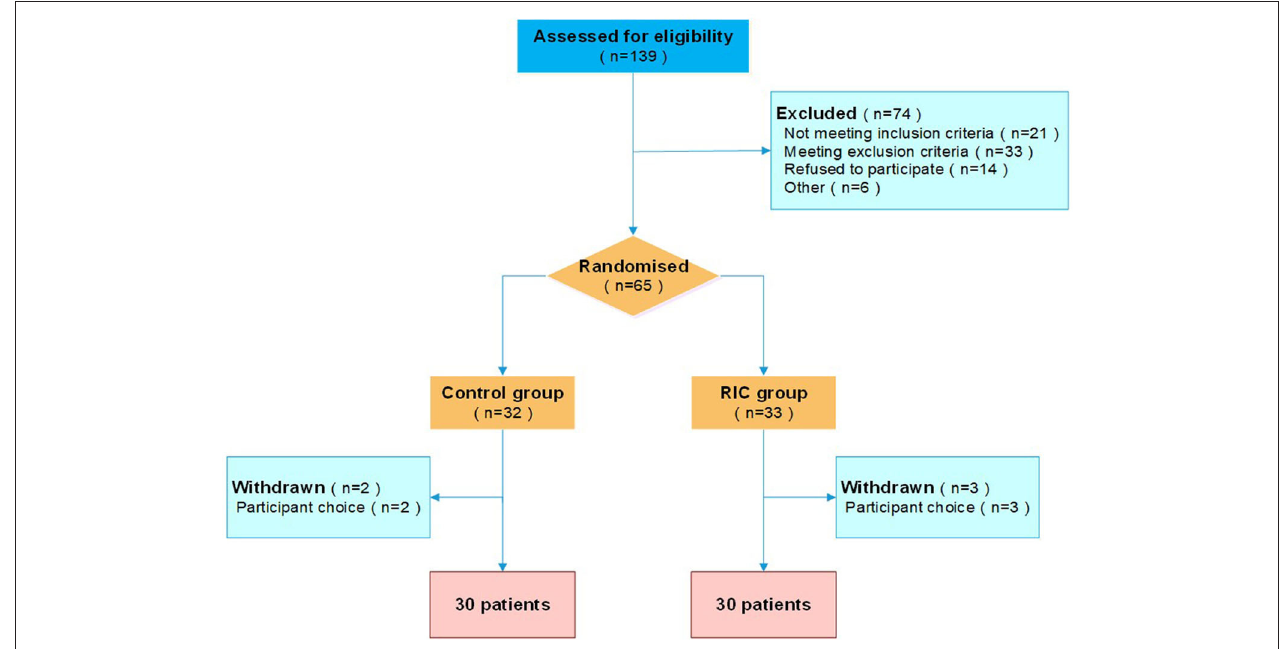
FIGURE 1 | Patient flow chart. RIC, remote ischemic